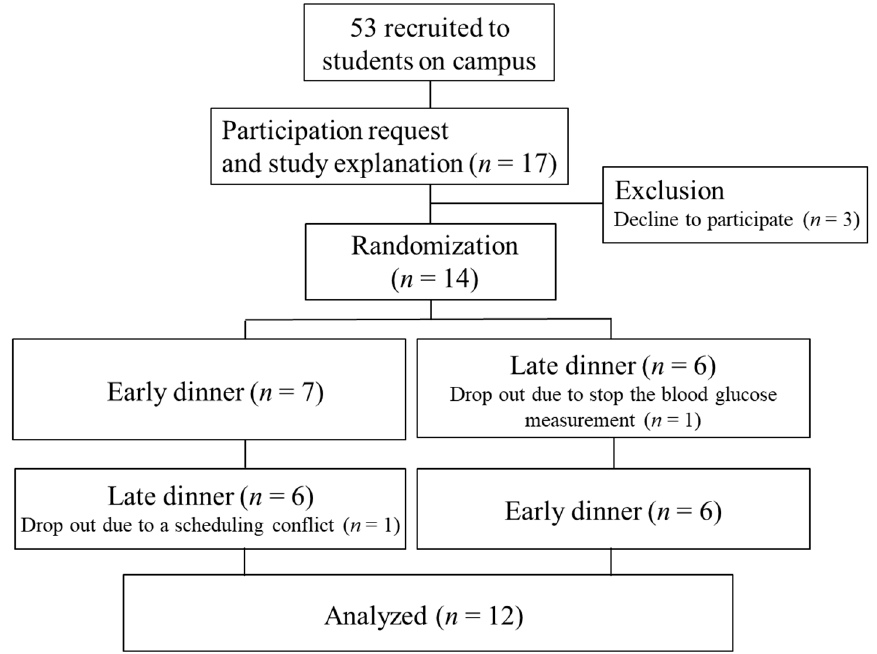
Figure 1. The flow diagram of the participant.